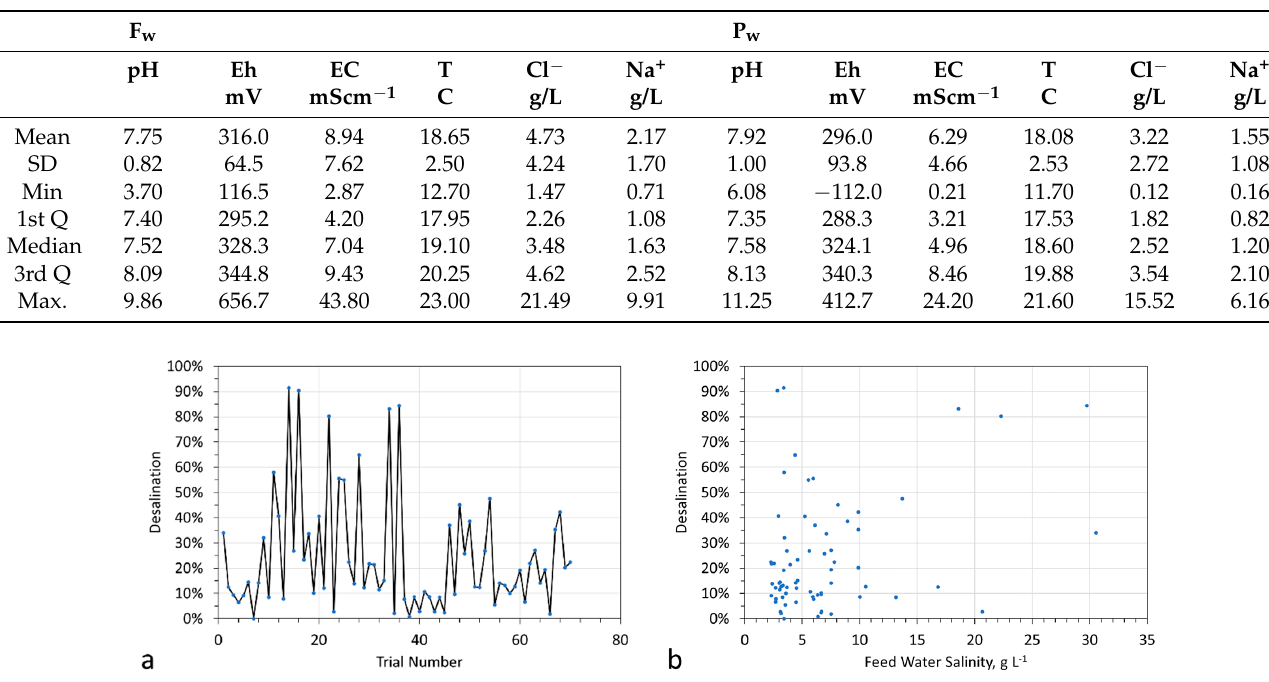
Table 1. Statistical parameters. F w = feed water; P w = product water. T = temperature; SD = standard